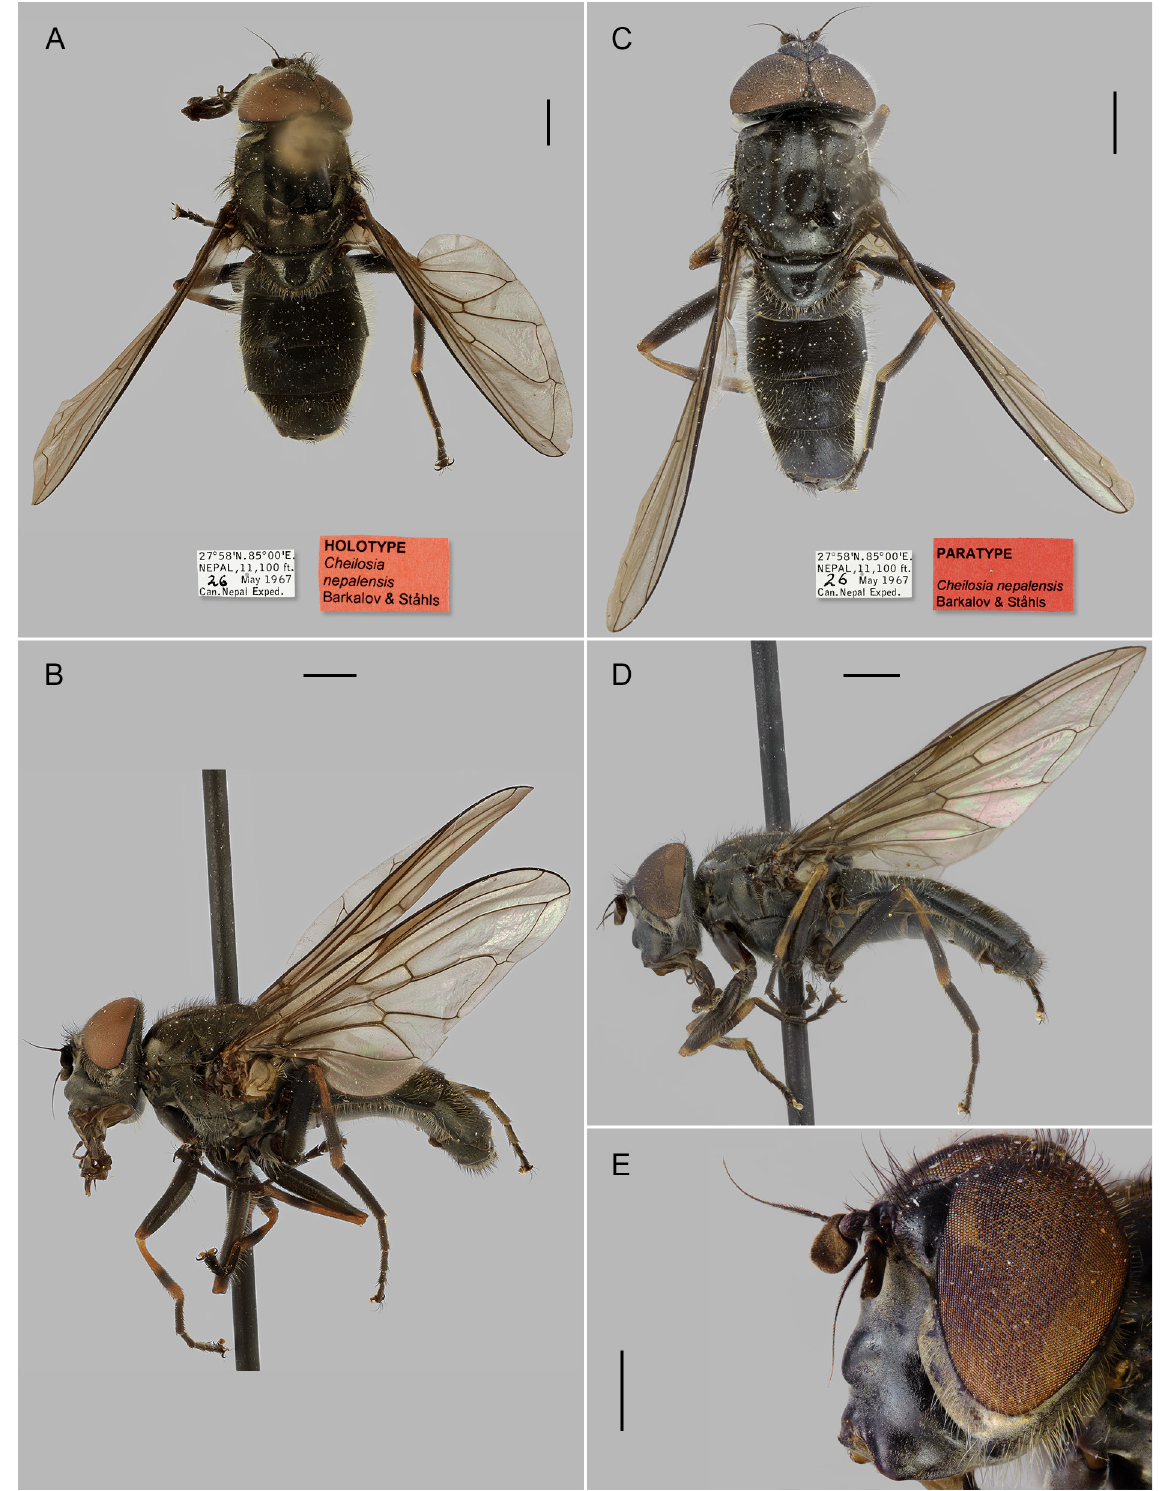
Fig. 44. Cheilosia ( Taeniochilosia ) nepalensis sp. nov. A–B . Holotype, ♂ (CNC); dorsal and lateral views. C–D . Paratype ♂ (CNC), dorsal and lateral views. E . Holotype, head. Photo: Pekka Malinen, FMNH Luomus. Scale bars: A–D = 1 mm; E = 0.5